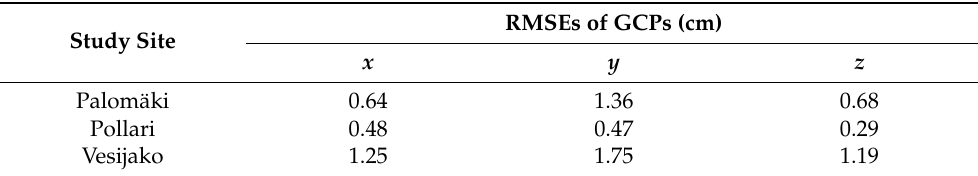
Table 3. The average root mean square errors (RMSEs) of ground control points (GCPs) for x -, y - and z -coordinates in each study site. RMSEs of GCPs (cm) Study Site x y Palomäki Vesijako